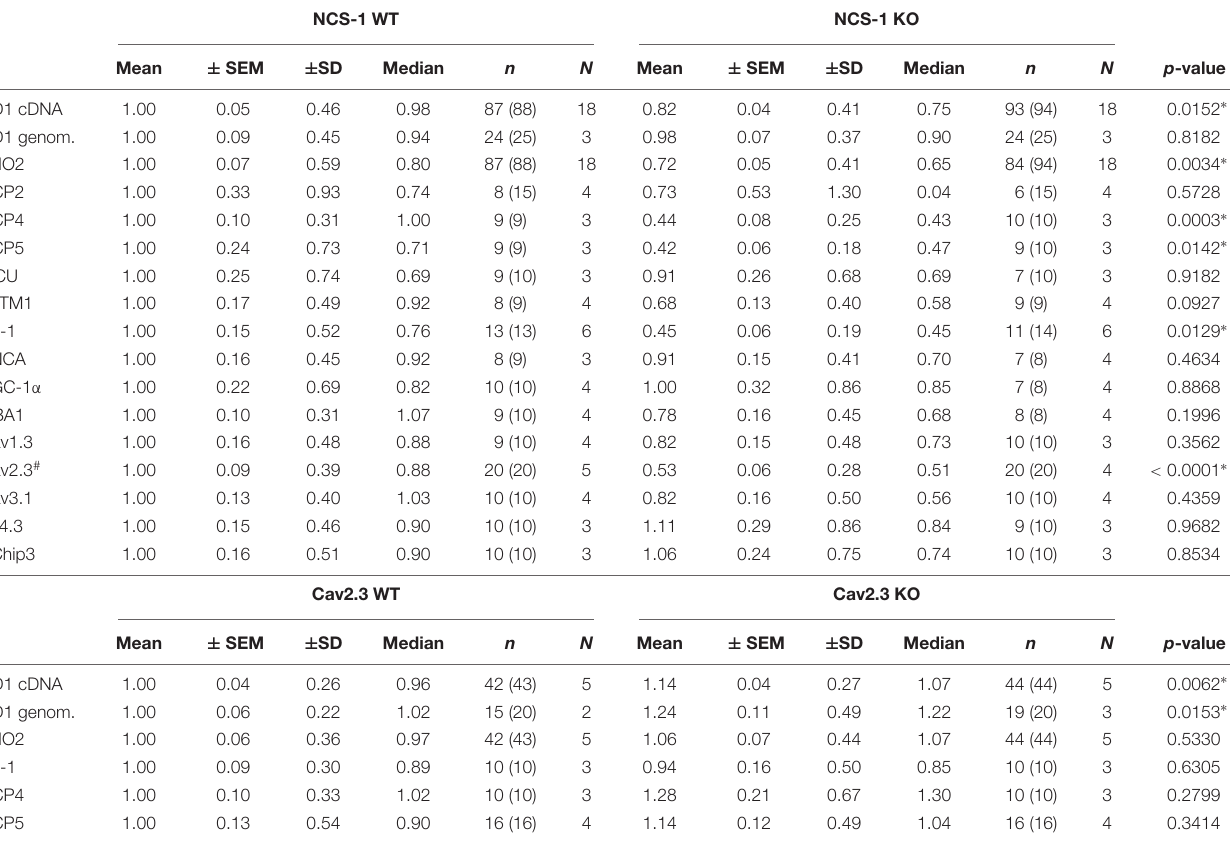
TABLE 2 | Relative mRNA levels in SN DA neurons of either NCS-1 KO or Cav2.3 KO, normalized to individual cell sizes, and to respective WT data.